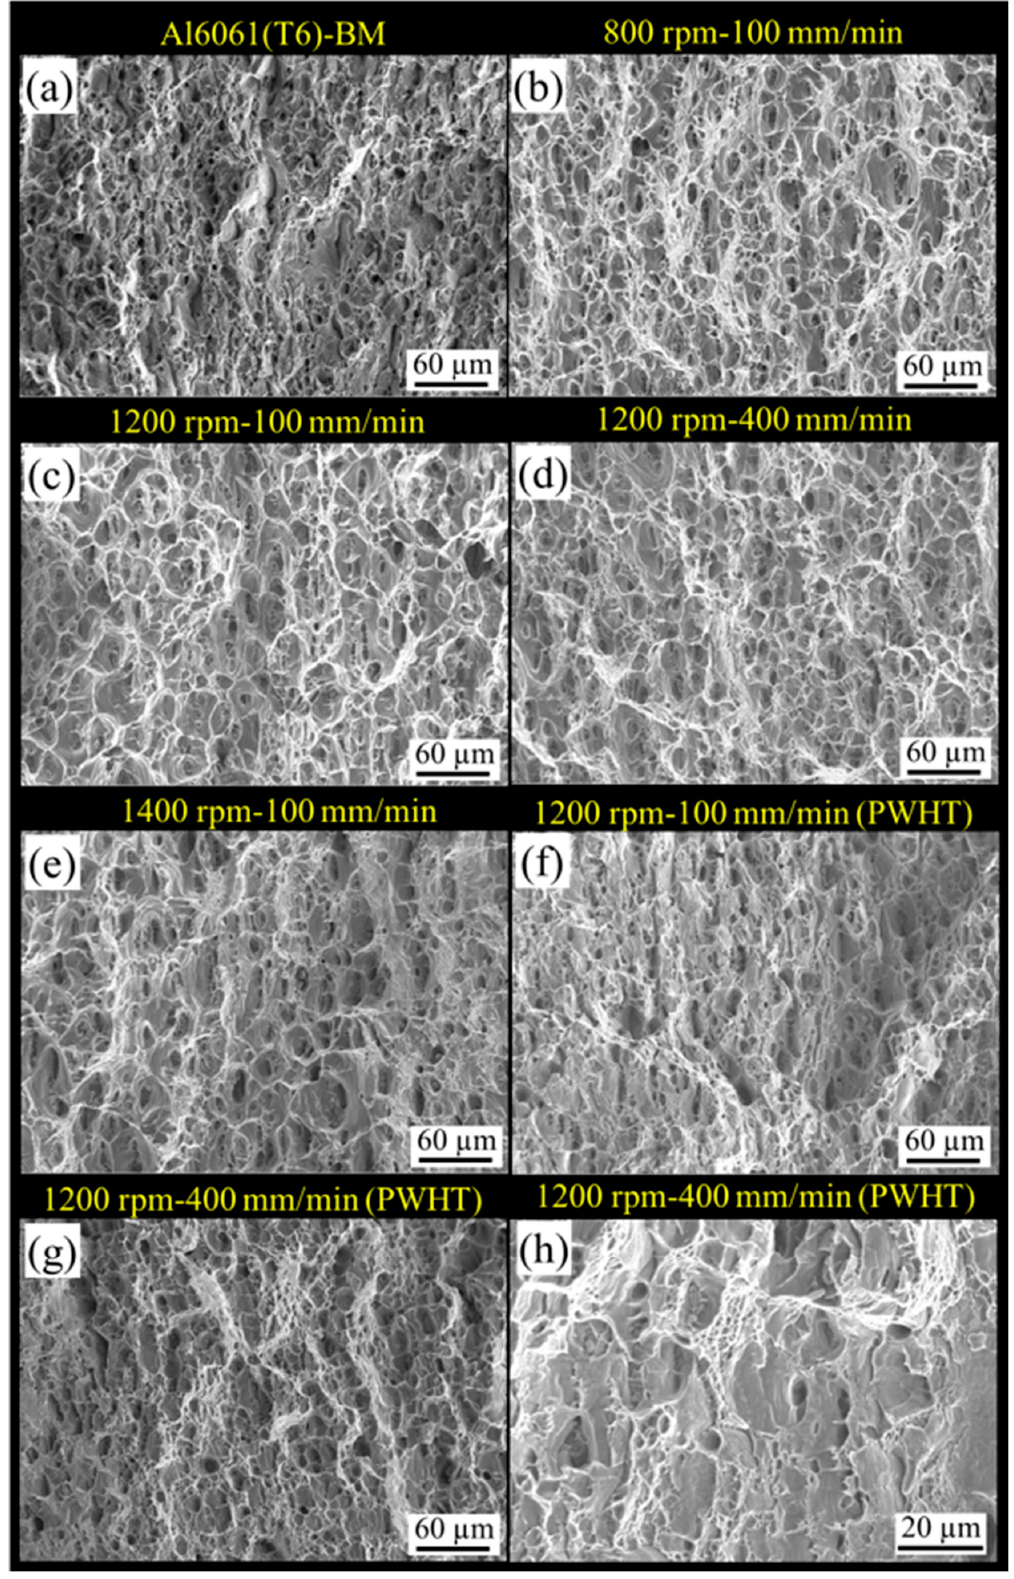
Figure 12. Tensile fracture surfaces of similar joints of Al6061(T6).